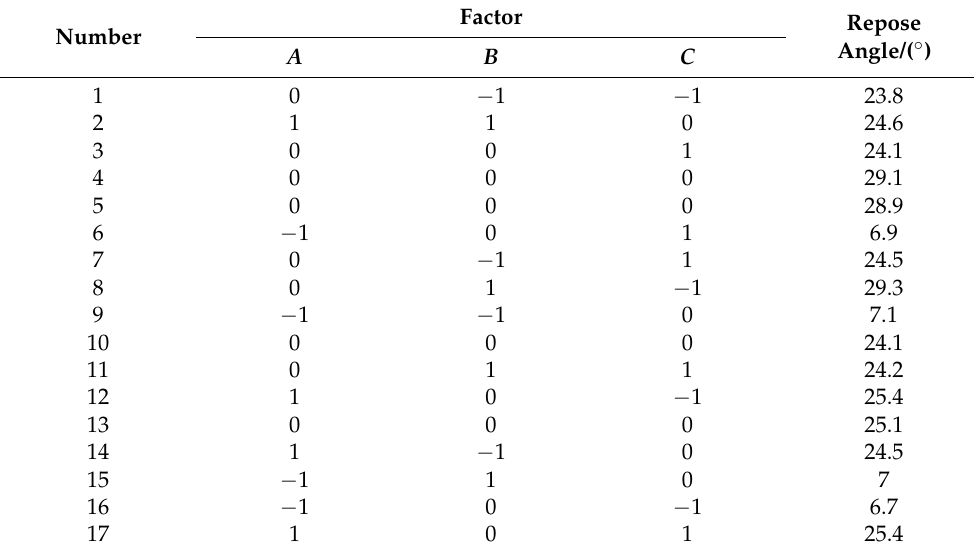
Table 6. Basic parameters for the soil particles and geometry in the discrete element method.